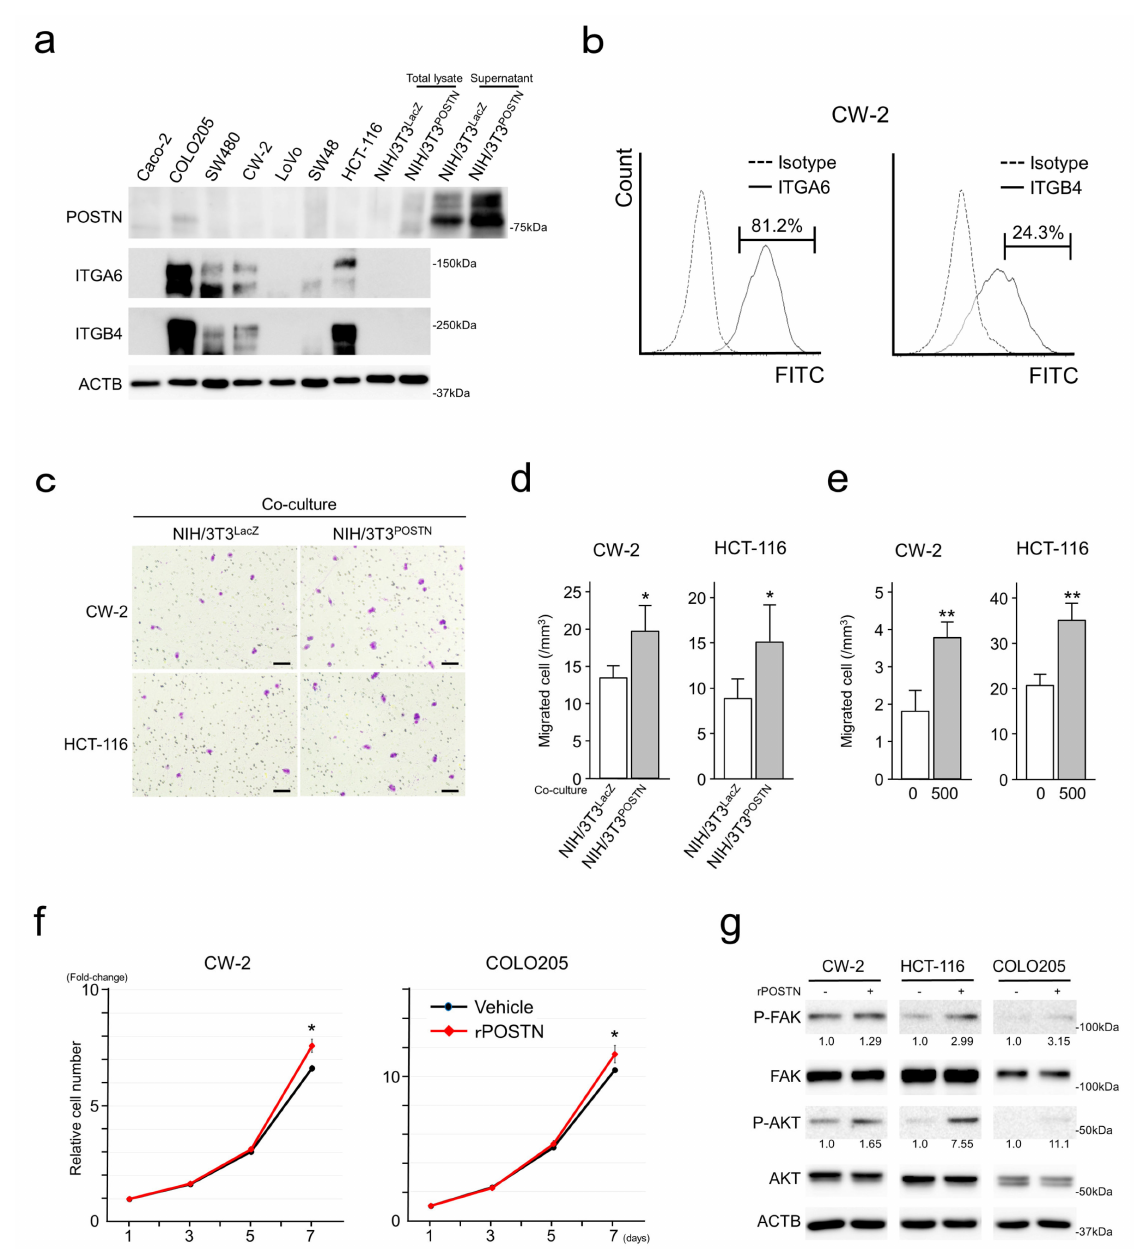
Figure 5. Effects of POSTN on CRC cells. ( a ) Immunoblot analysis showing POSTN and ITGs in CRC and NIH/3T3 cells. ( b ) Results for FACS analyses showing ITGA6 and ITGB4 expression on CW-2 cells. ( c – e ) Results of migration assays showing that co-culture with NIH/3T3 POSTN or addition of rPOSTN in the lower chamber accelerated the migration of CRC cells. Bar = 100 µ